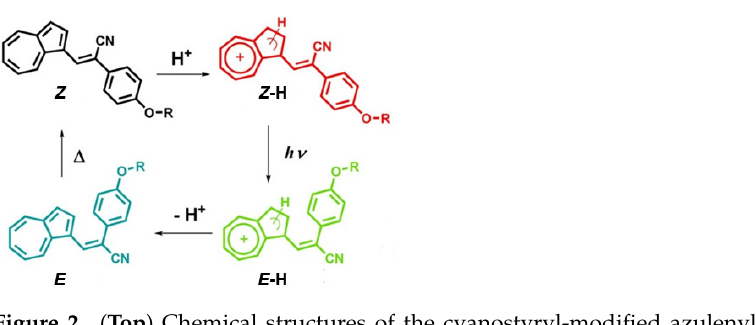
Figure 2. ( Top ) Chemical structures of the cyanostyryl-modified azulenyl compounds 2 and 3 . Figure 2. (Top) Chemical structures of the cyanostyryl-modified azulenyl compounds 2 and 3 . (Bot- Figure 2. (Top) Chemical structures of the cyanostyryl-modified azulenyl compounds 2 and 3 . (Bot- ( Bottom ) Protonation-assisted photoisomerization process. Adapted with permission from [37]. tom) Protonation-assisted photoisomerization process. Adapted with permission from [37]. Figure 2. (Top) Chemical structures of the cyanostyryl-modified azulenyl compounds 2 and 3 . (Bot- tom) Protonation-assisted photoisomerization process. Adapted with permission from [37]. tom) Protonation-assisted photoisomerization process. Adapted with permission from [37].